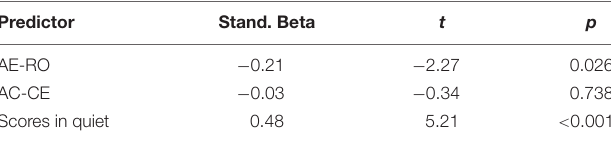
TABLE 7 | Beta-weights of AE-RO, AC-CE and comprehension scores in quiet as the predictors of English listening comprehension in English babble. Predictor Stand.